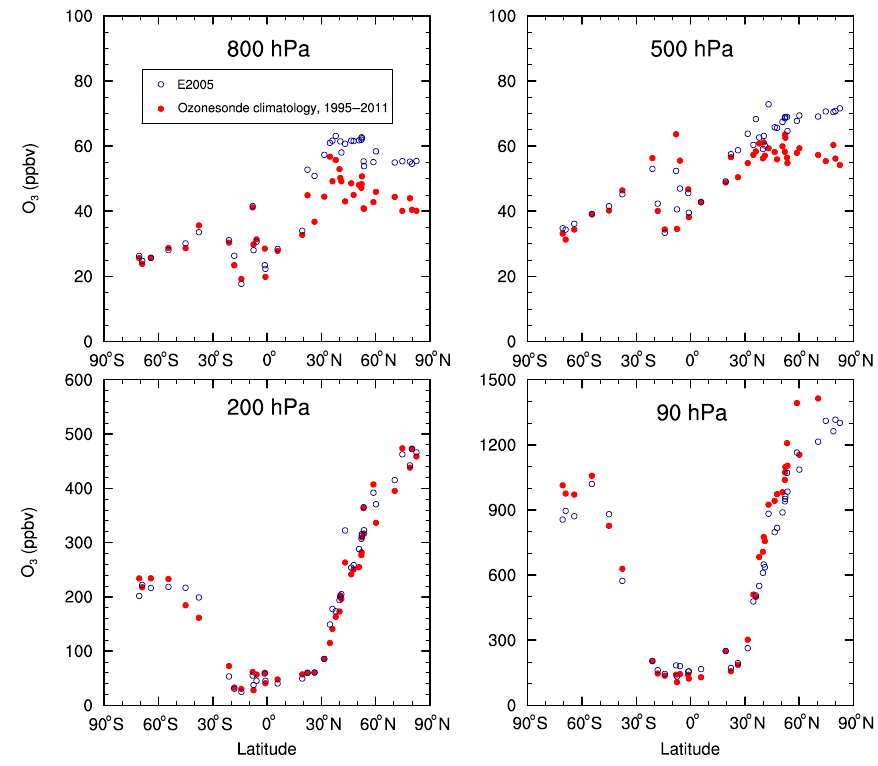
Figure 7. Annual-mean ozone concentration (ppbv) at 41 locations for four pressures for both the E2005 simulation and the Tilmes et al. (2012) ozonesonde